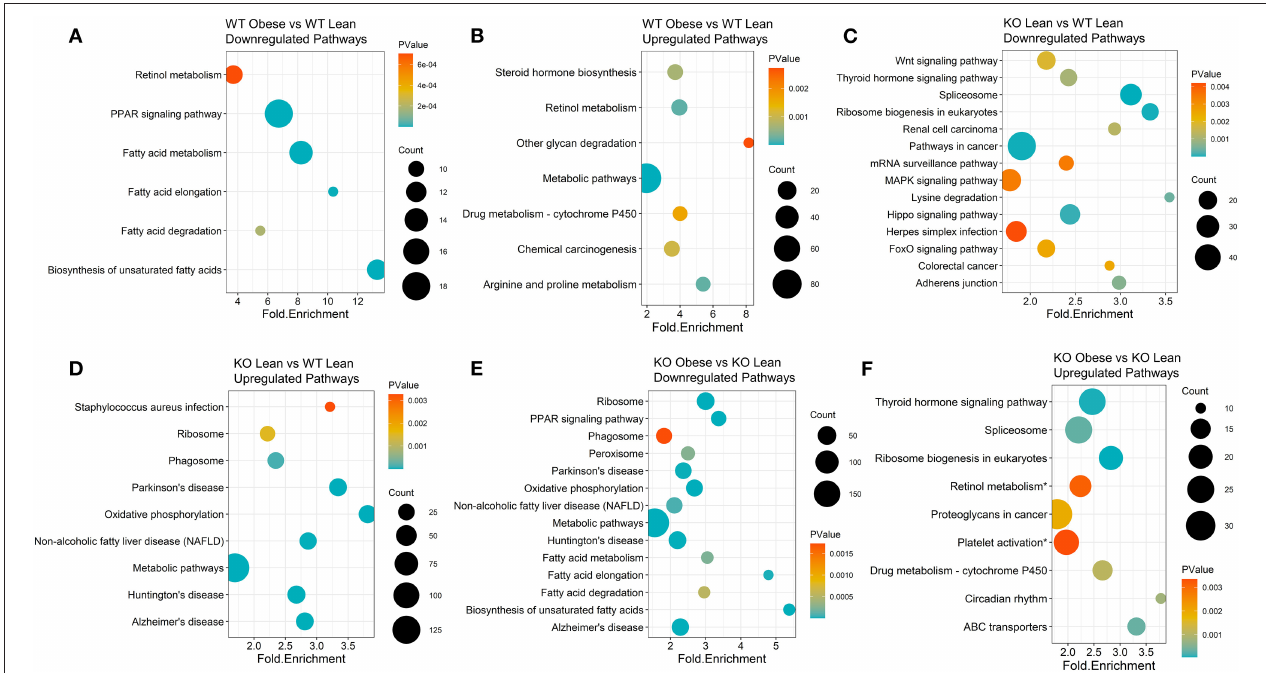
FIGURE 2 | KEGG pathway clusters capture diet and genotype effects of differentially expressed genes transcripts of obese WT and ChemR23 KO mice. KEGG pathway clusters are listed for each comparison where the sizes of the dots on the plot indicate the number of genes in the KEGG pathway cluster, the p-value is denoted in a colored blue-orange scale, and each pathway is plotted by its fold enrichment value. (A) Downregulated KEGG pathways between WT obese and WT lean mice. (B) Upregulated KEGG pathways between WT obese and WT lean mice. (C) Downregulated KEGG pathways between ChemR23 KO lean and WT lean mice. (D) Upregulated KEGG pathways between ChemR23 KO lean and WT lean mice. (E) Downregulated KEGG pathways between ChemR23 KO obese and KO lean mice. (F) Upregulated KEGG pathways between ChemR23 KO obese and ChemR23 KO lean mice. Data are from 7 mice per